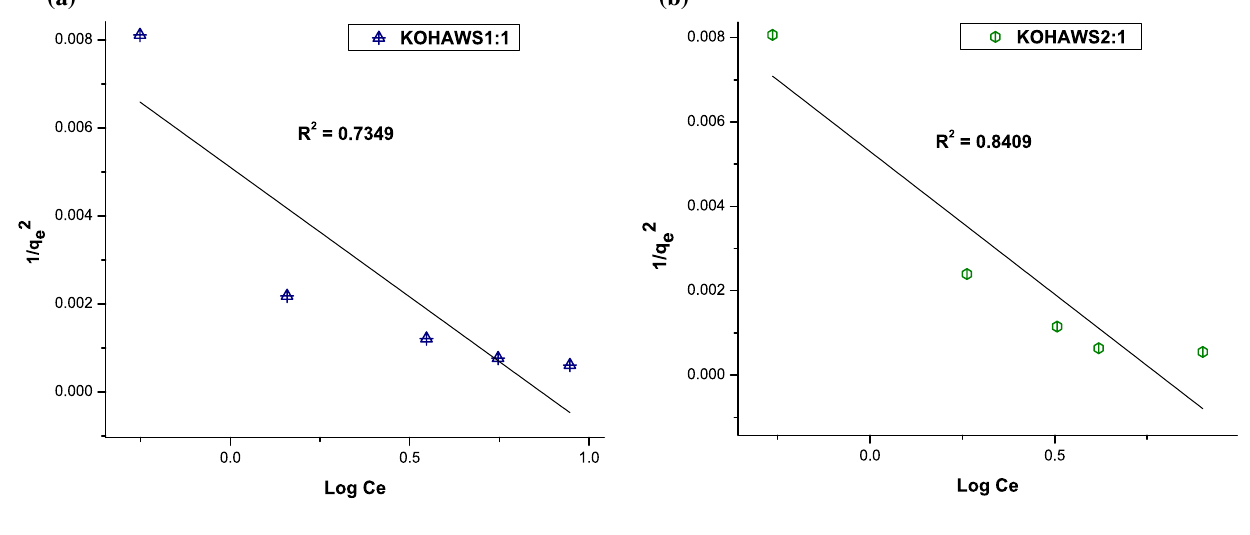
Fig. 13 Harkin–Jura isotherm for a KOHAWS1 and b